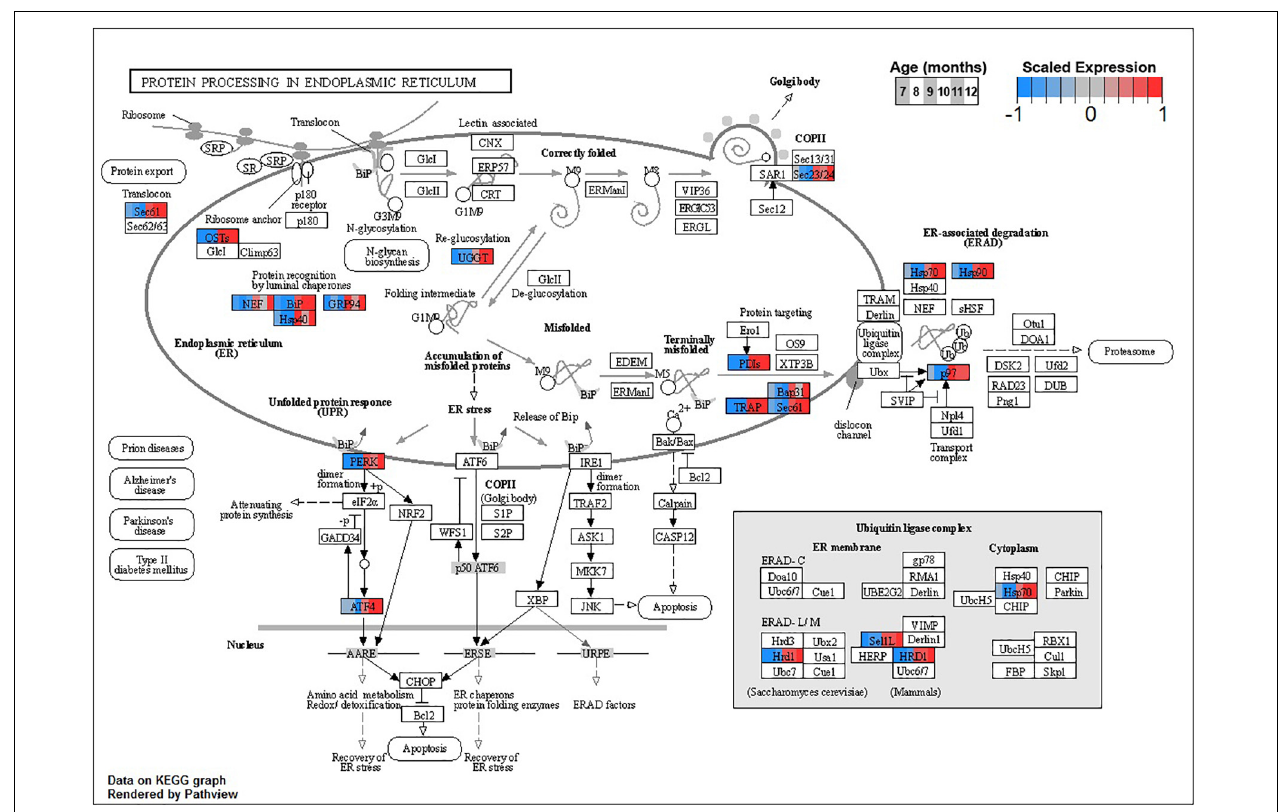
FIGURE 5 | Expression of orthologs annotated for the Kyoto Encyclopedia of Genes and Genomes (KEGG) protein processing in Endoplasmic Reticulum (ko04141) pathway present in buccal S sensory neuron (BSC) expression clusters with increasing trend (B1 and B2). Each node of the pathway diagram represents an ortholog assigned to an Aplysia californica transcript. Nodes are divided into six colored sections, from left to right, ages 7 to 12 months. Node sections are colored according to their mean centered- and variance scaled-expression, together representing the expression trends of each node across the aging process. Nodes that are not colored were absent from the gene sets of expression clusters B1 and B2. Pathway enrichment demonstrates broad upregulation of proteostatic processes in the endoplasmic reticulum with